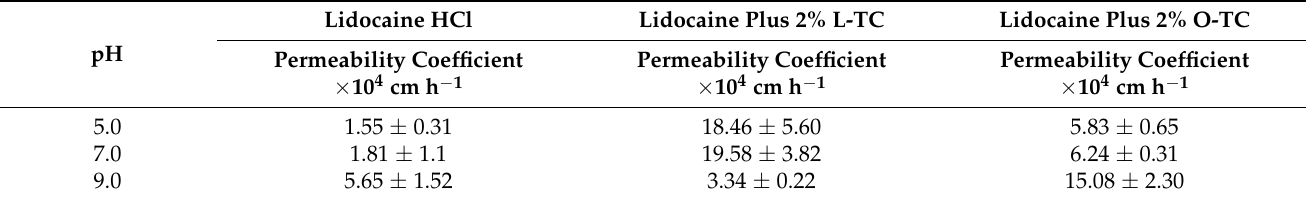
Table 15. Apparent permeability coefficients for different pH values for lidocaine HCl and in the presence of L-TC and O-TC. According to the authors, saturated solutions of lidocaine were used ( n = 6, values represent the mean ± S.D.) Adapted with permission from [48], Elsevier, 2005.